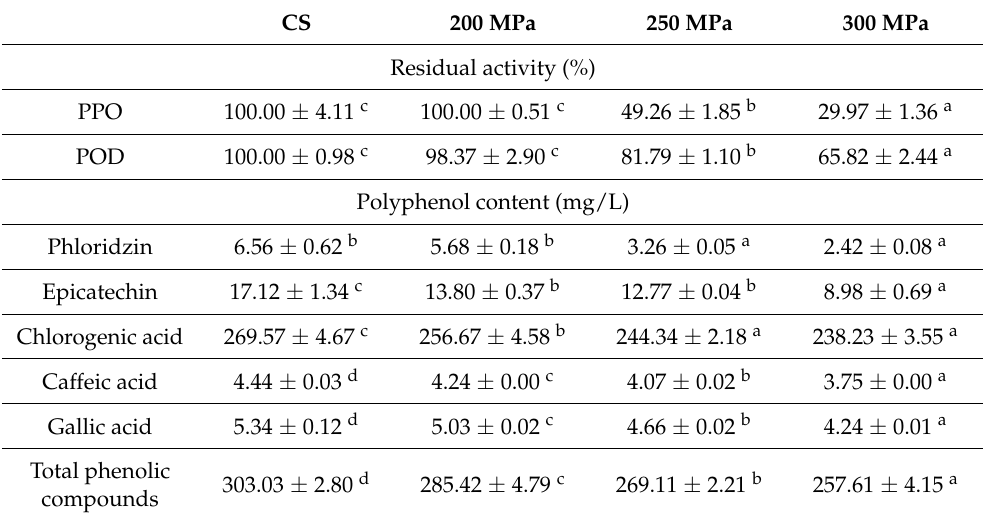
Table 2. The enzyme activity and polyphenol contents of apple juice after being treated using HPH